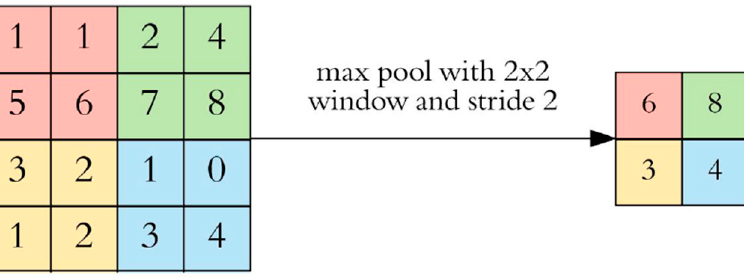
Figure 2. The application of max pooling on the input.